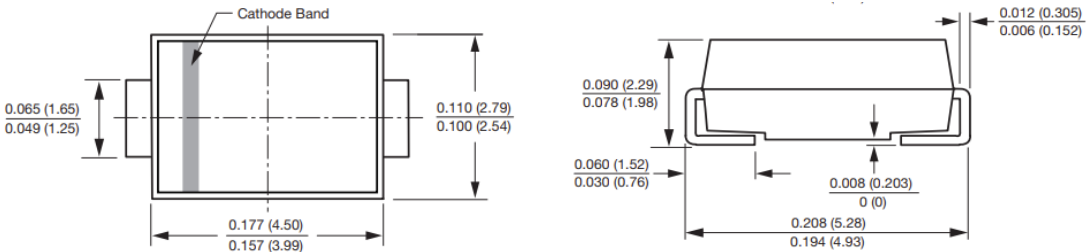
Figure 9. US1MHE3 Package dimensions from datasheet.